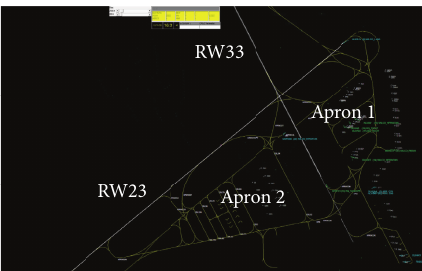
Figure 8: Hamburg Airport. RW33 is approximately oriented in north-south direction. Apron 1 is to the east of RW33 and apron 2 to the west; both aprons are south of RW23; screenshot from NAVSIM air traffic simulator as presented to the air traffic